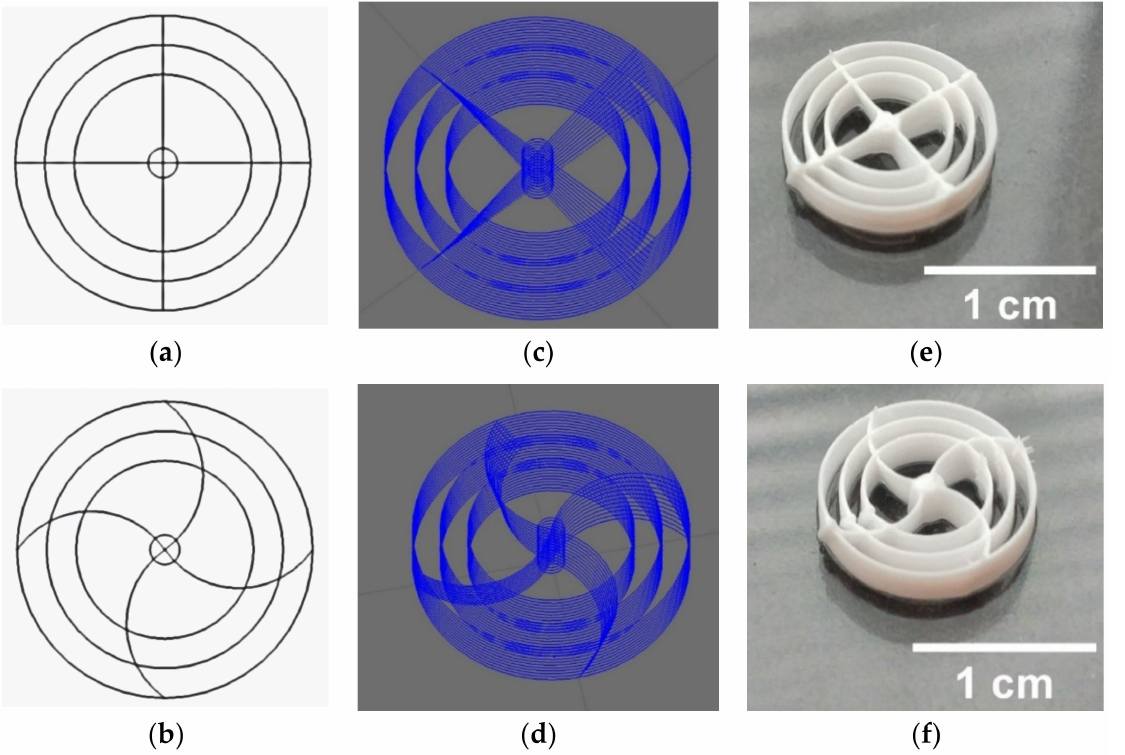
Figure 1. From concept to finished 3D print: ( a , b ) CAD models of the round structures with ( c ) straight spokes and ( d ) wavy spokes; stacked models with 12 layers and a rotation of 1 ◦ per layer for ( e ) straight spokes and ( f ) wavy spokes. CAD models created with CREO